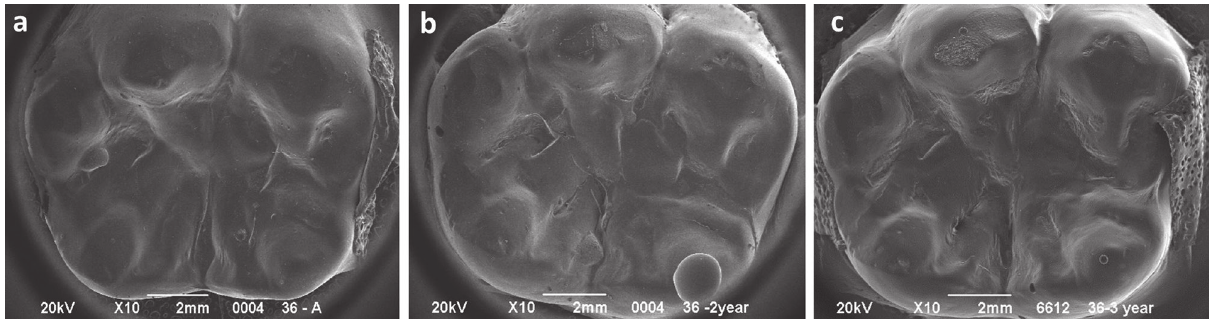
Figure 2- Representative scanning electron microscopy (SEM) micrographs of the infiltrant at (a) the baseline, (b) after 2 years, and (c) 3 years of clinical follow-up. The wear pattern of the material created a uniform surface, which is less favorable to biofilm accumulation